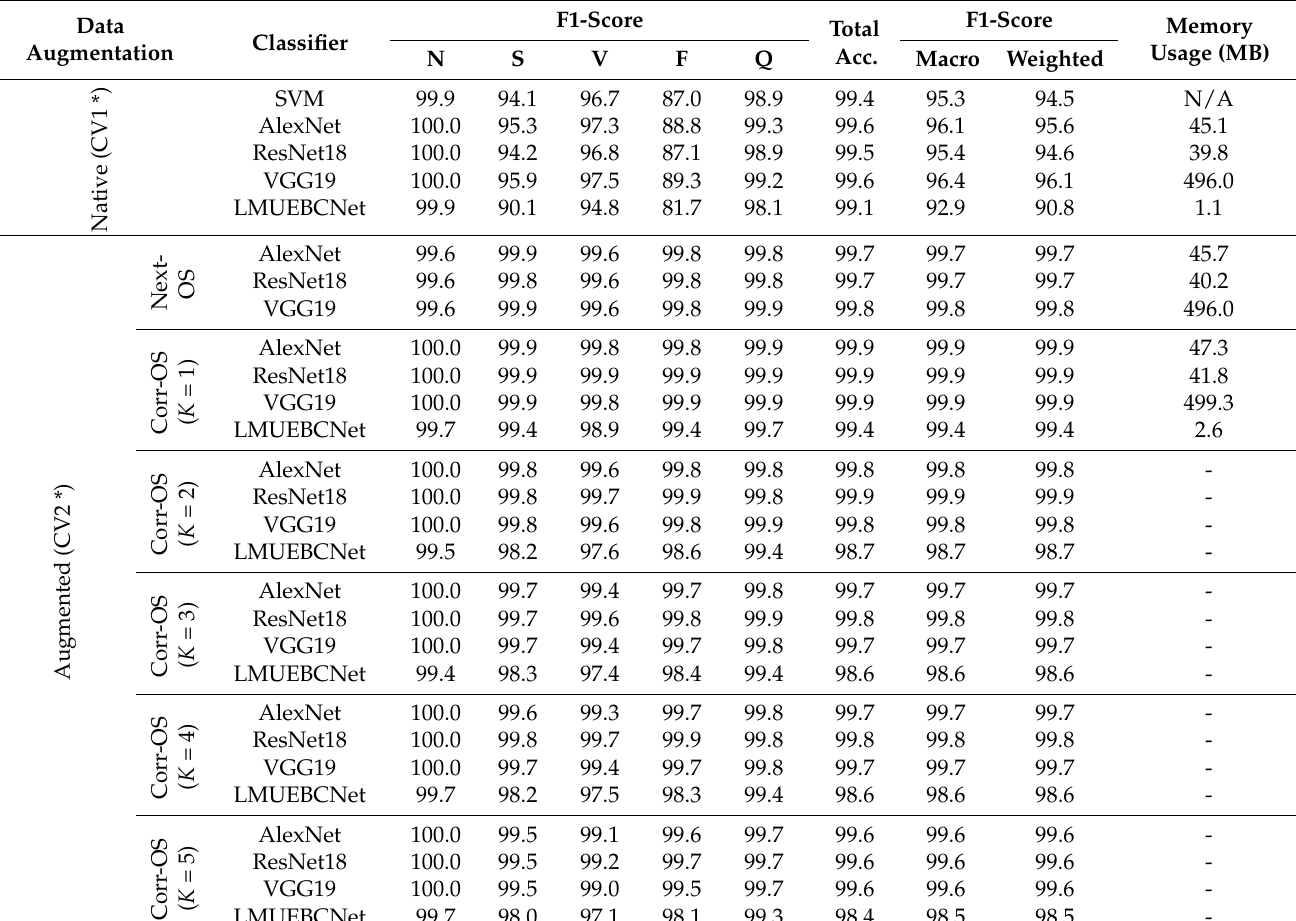
Table 4. Classification performance between LMUEBCNet with existing models using native/Corr- OS/Next-OS dataset under